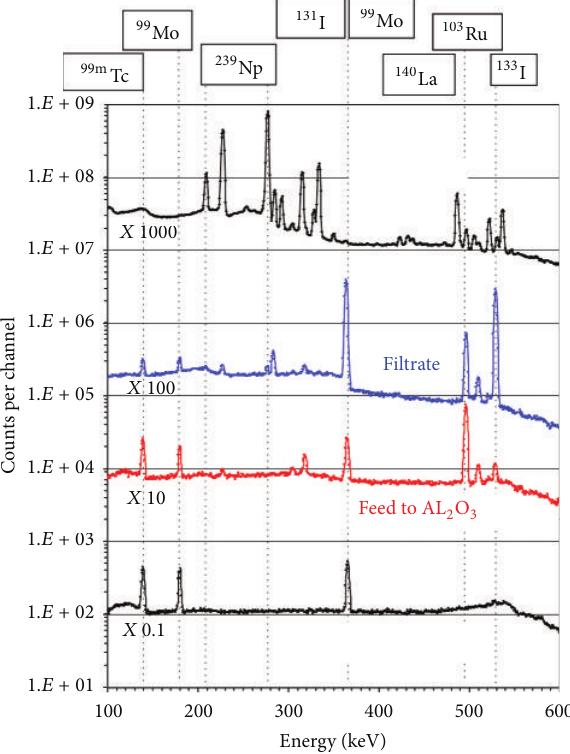
Figure 7: 99 Mo elution profile from the DOWEX-1 column with 1M (NH 4 ) 2 CO 3 -solution using the parameters shown in Table 3. Figure 8: Gamma spectra of samples from the precipitate, filtrate,